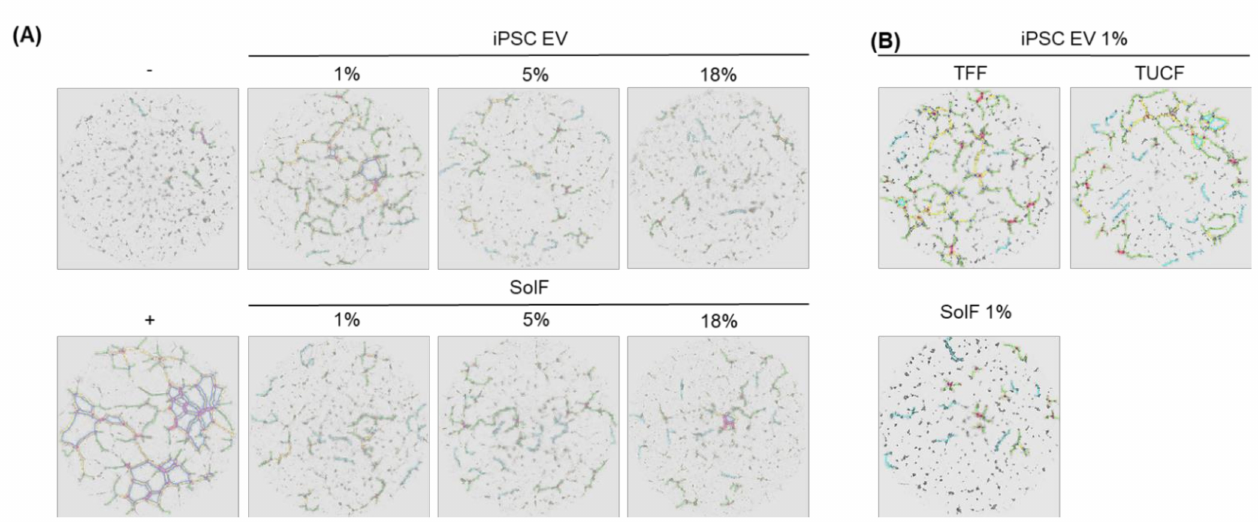
Figure A2. Angiogenic potential of iPSC-EVs. ( A ) Representative endothelial networks in the presence of iPSC EV obtained from iPSC cultures at different oxygen level as indicated compared to negative ( − ) and positive (+) control, respectively. ( B ) Endothelial networks in the presence of iPSC-EV derived from hypoxic 1% oxygen culture and isolated by TFF or TUCF and compared to addition of equivalent volume of soluble factors (SolF) corresponding to the TFF preparation. Representative images from three independent experiments showing network detection by imageJ plugin Angiogenesis